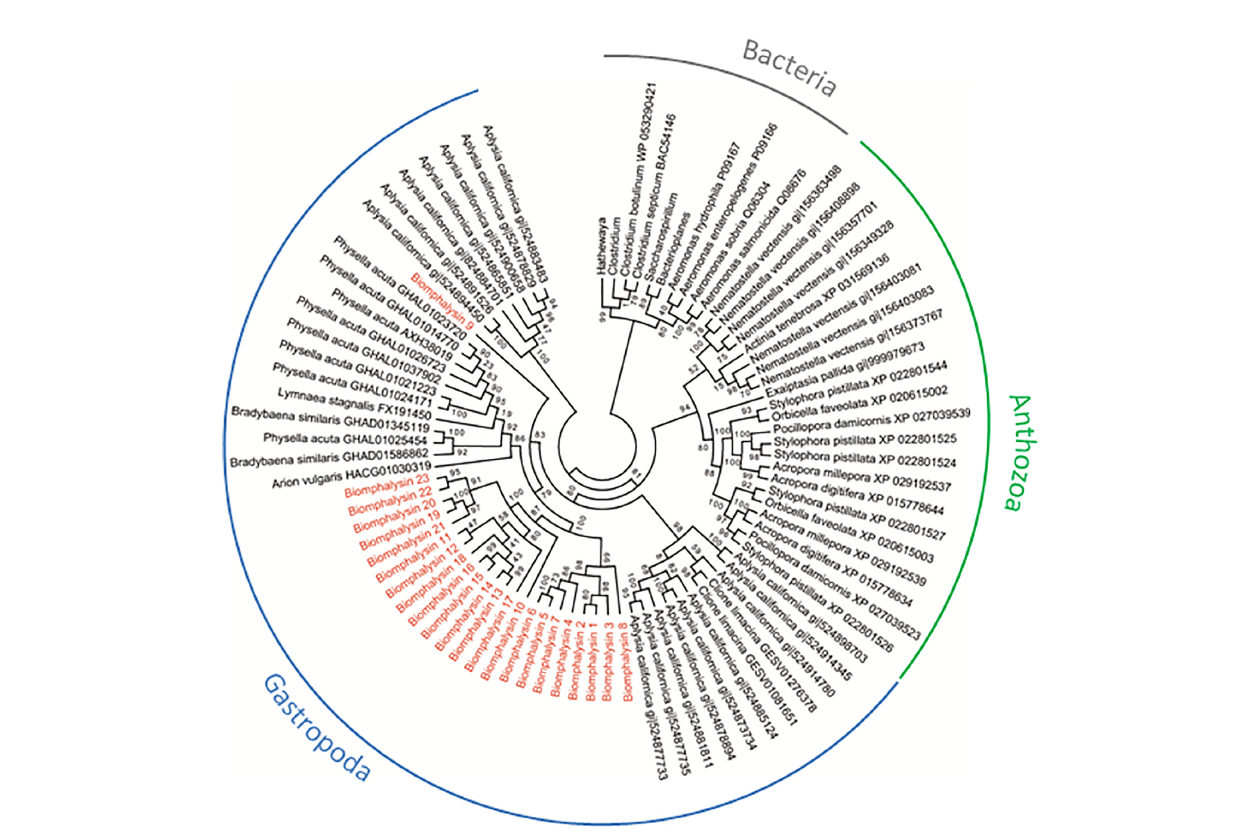
FIGURE 2 | Phylogenetic tree of biomphalysins with other proteins bearing ETX/MTX2 domain. Phylogenetic analysis was conducted from 87 ETX/MTX2 protein domain sequences from biomphalysins and related sequences from other organisms. Protein sequences were aligned using Clustal Omega. Multiple alignment was trimmed using Gblocks, and tree was constructed by Maximum likelihood analysis using PhyML. Values on the branches indicate the robustness of the branches of the tree inferred by ML method. Biomphalysins (red) clustered together with other Gastropoda sequences (blue). Sequences from Anthozoa (green) and Bacteria (gray) formed two other distinct clusters. The accession number of each gene and protein used is listed in Table S9